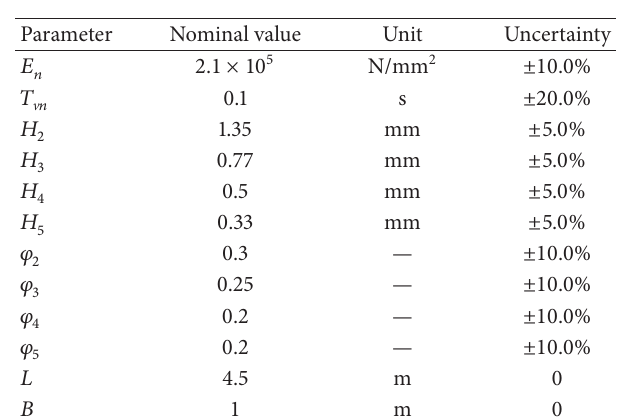
Table 1: Nominal values and their tolerance.